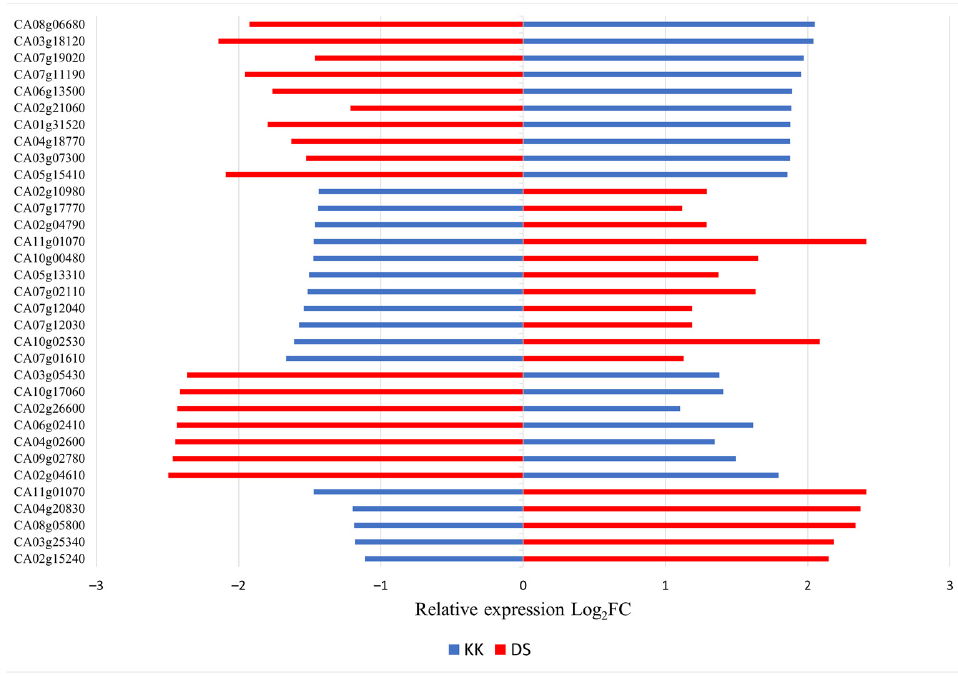
Figure 3. Genes with inverse expression patterns in two pepper cultivars in response to PSTVd at 43 dpi, identified by RNA seq. The comparison of the expression levels of mock (KKH, DSH) and PSTVd infected (KKI, DSI) was performed using the DESeq2 package.